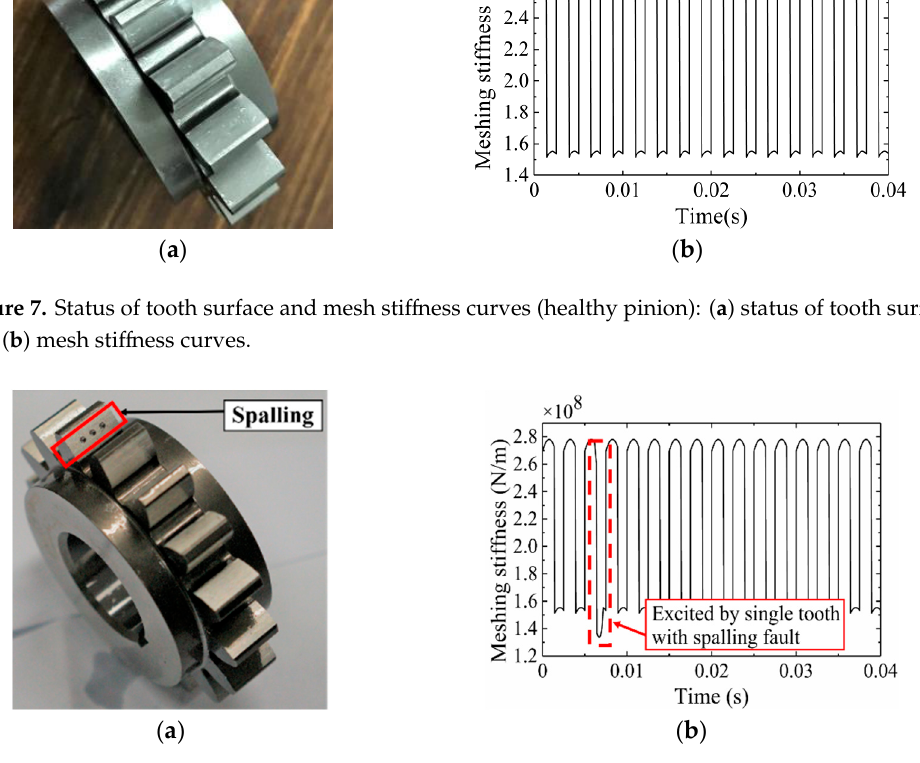
Figure 8. Status of tooth surface and mesh stiffness curves (single tooth with spalling fault): ( a ) status of tooth surface and ( b ) mesh stiffness curves.